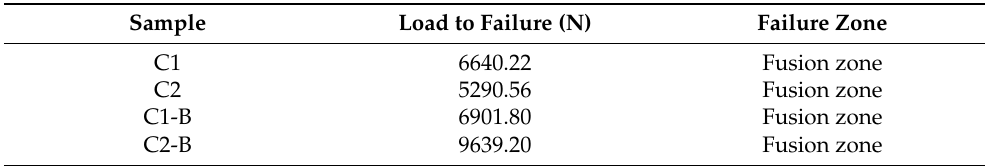
Table 3. Mechanical properties of the lap welded joints